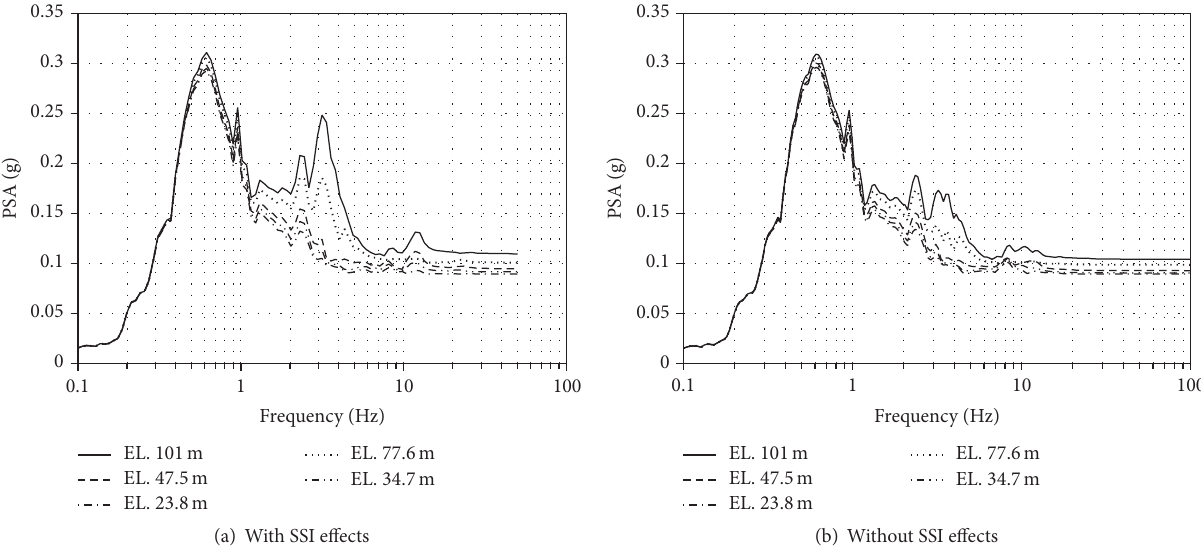
Figure 8: Response spectral acceleration for different elevations of the Reactor Containment Building under horizontal excitation M1. iteration variable are greater than those from the other two analysis methods. For frequencies greater than 1 Hz, which is of interest for in-structure response analysis, the response spectral displacement of the different analysis methods showed limited